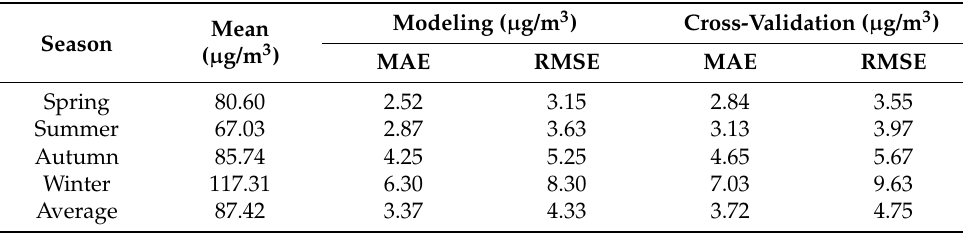
Table 2. Error indices for LUR models for the different seasons during the modeling period and the cross-validation period.